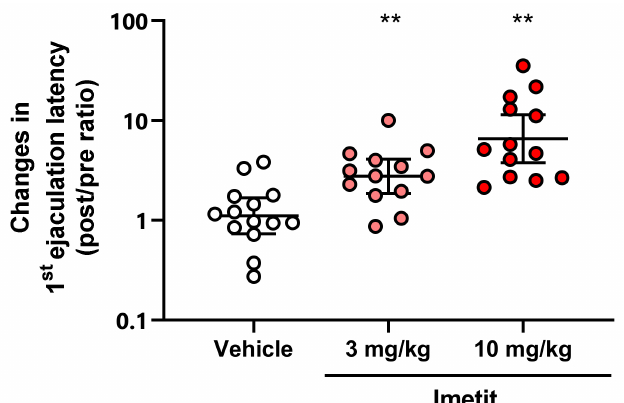
Figure 7. Effect of imetit on the fold change in ejaculation latency in rats. Data are presented as the geometric mean with the 95% confidence interval (n = 13). ** p < 0.01 vs. vehicle group analyzed using Dunnett’s multiple comparison